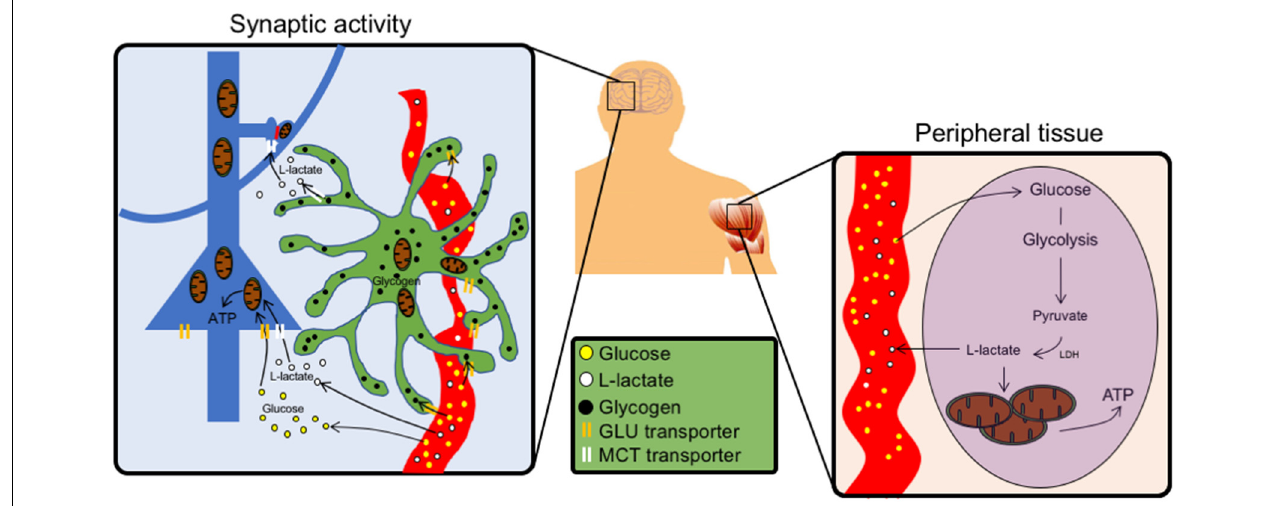
FIGURE 1 | Schematics of the peripheral vs. central action of L-Lactate. Left , In the brain, neurons (blue) can uptake glucose using glucose transporters (GLUTs) and use it as a source of energy at the level of their soma. Around synapses, astrocytes (green) take up glucose from the blood vessels (red) and store it as glycogen granules (black). Upon synaptic activity, astrocytes produce L-Lactate in proximity of synapses, which express monocarboxylate transporter (MCT) transporters to import lactate as local source of energy. Lactate can also be formed from glycogen, the storage form of glucose. Right , In peripheral tissues glucose fuels tricarboxylic acid (TCA) cycle via circulating lactate through